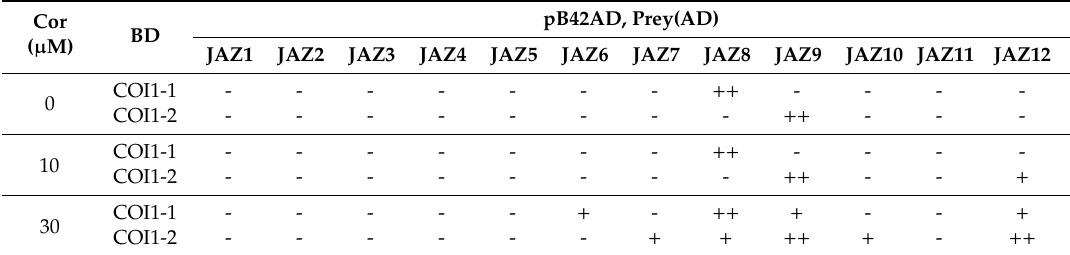
Table 4. Yeast two-hybrid analysis. The results of the interaction between JAZ and